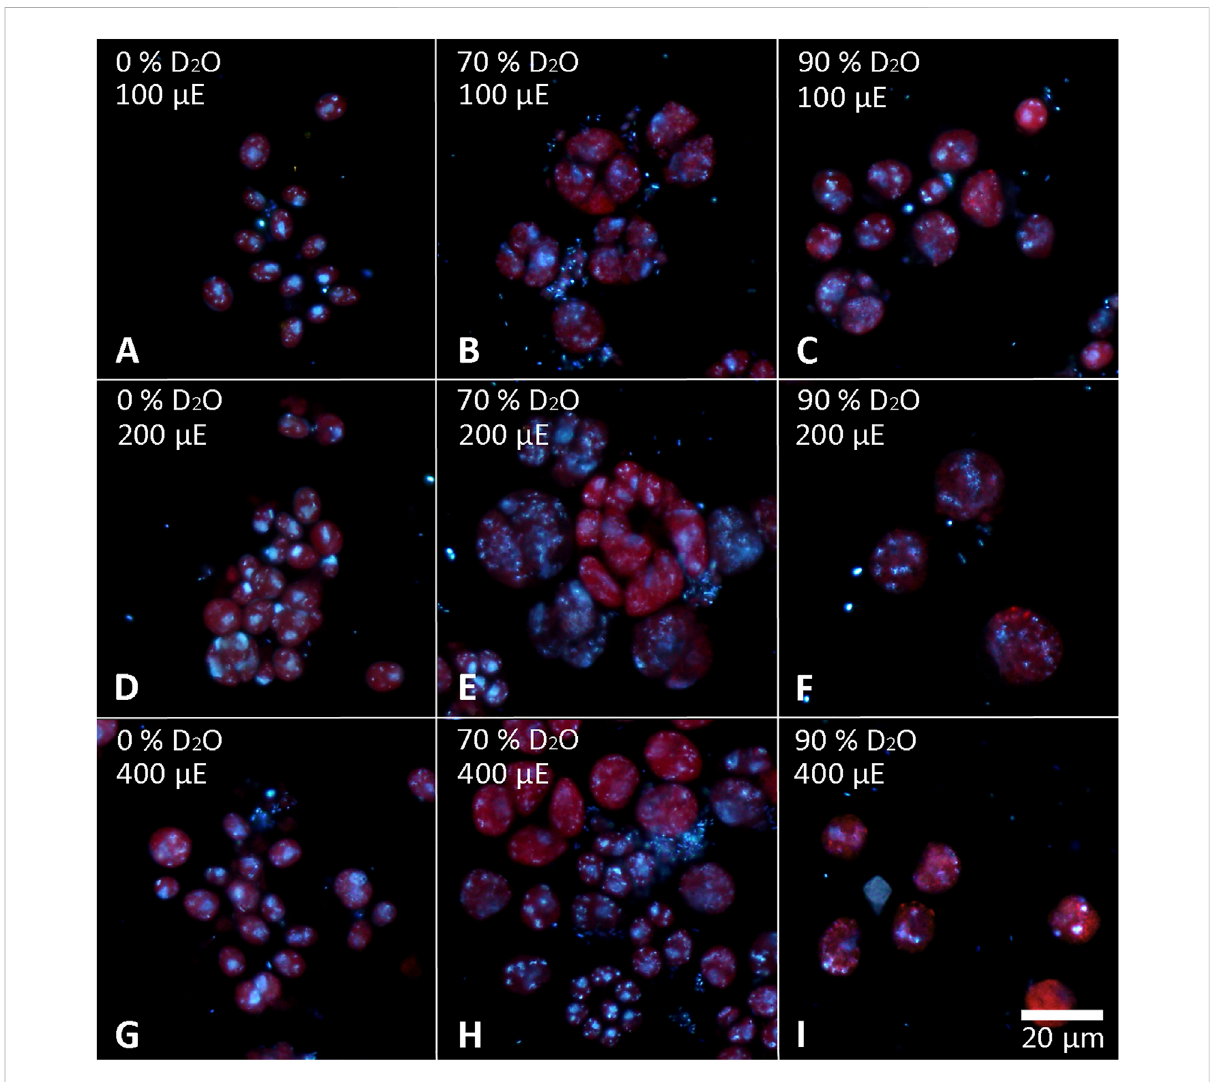
FIGURE 9 Cellsof C.reinhardtii stainedwithDAPItovisualizethenuclei.Cellsculturedin0 (A,D,G) ,70 (B,E,H) or90% (C,F,I) D2O(fromlefttoright)atanincidentlight intensityof100 (A,B,C) ,200 (D,E,F) or400 (G,H,I) μ molphotons · m − 2 · s − 1 (denotedas μ Einthe fi gure;fromtoptobottom)werestainedafter48